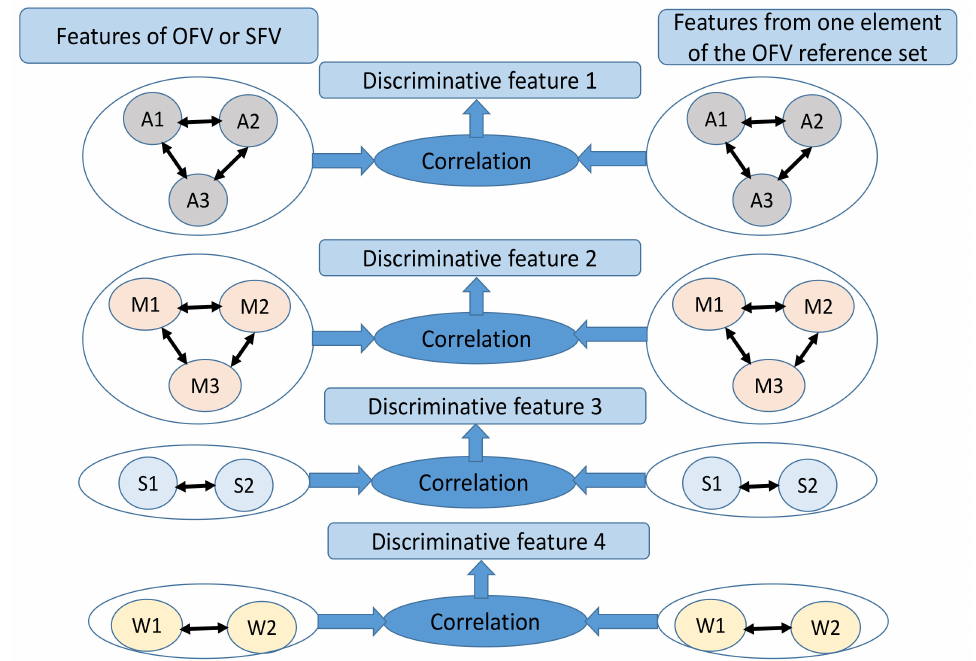
Figure 4. Graph model and structured correlation between OFV or SFV and the OFV reference set. Sensor acronyms refer to Figure 1 nomenclature: A, accelerometer; M, microphone; S, speed; W,